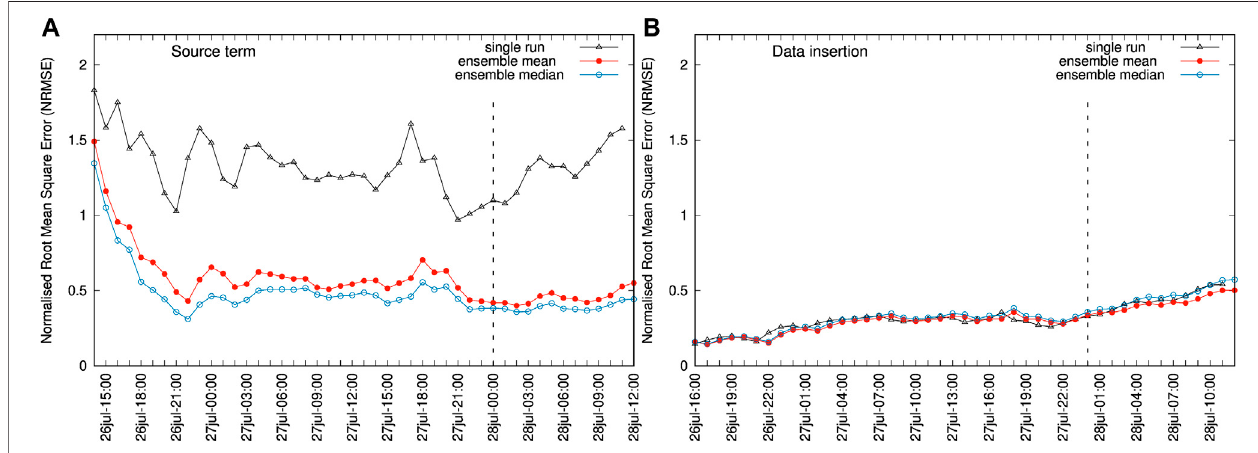
FIGURE2|(A) TimeseriesofNormalisedRootMeanSquareError(NRMSE)fortheAmbaesingle-run(blackline),ensemblemean(redline),andensemblemedian (blue line). The vertical dashed line marks the instant of the snapshot shown in Figure 1 . Symbols indicate the hourly AHI retrievals. (B) Same but with the source term givenbyadatainsertionmechanism. Inthiscase, theensembleisde fi nedbyperturbingonly theheightand thicknessoftheinjectedcloud asindicatedin Table4 .Plots on the same vertical